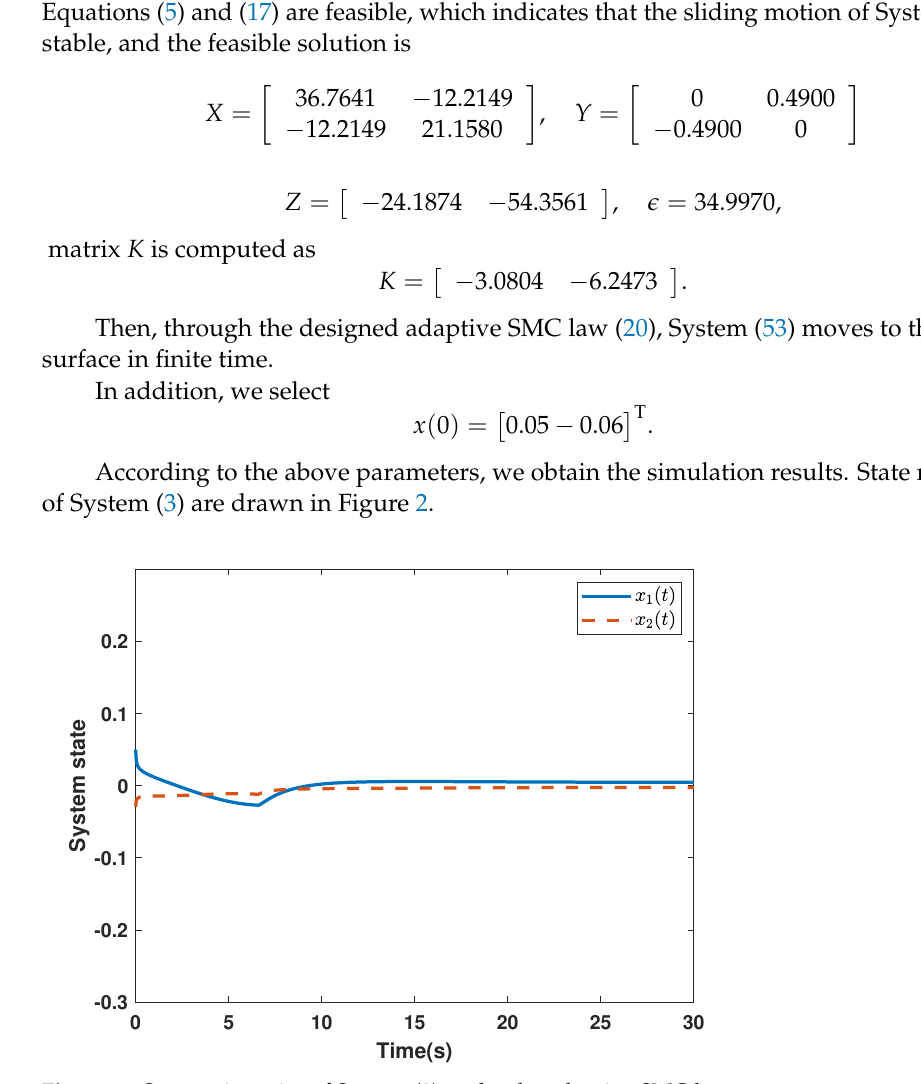
Figure 2. State trajectories of System (3) under the adaptive SMC